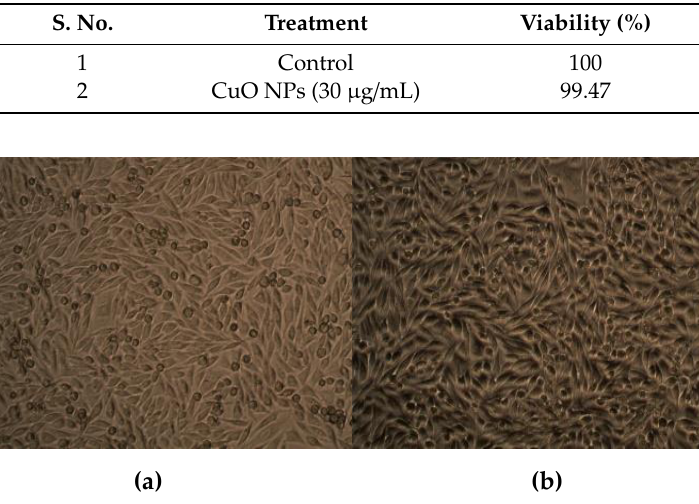
Figure 7. Effect of CuO NPs on the viability of human dermal fibroblasts: (a) control; (b) CuO NPs. Figure 7. E ff ect of CuO NPs on the viability of human dermal fibroblasts: ( a ) control; ( b ) CuO